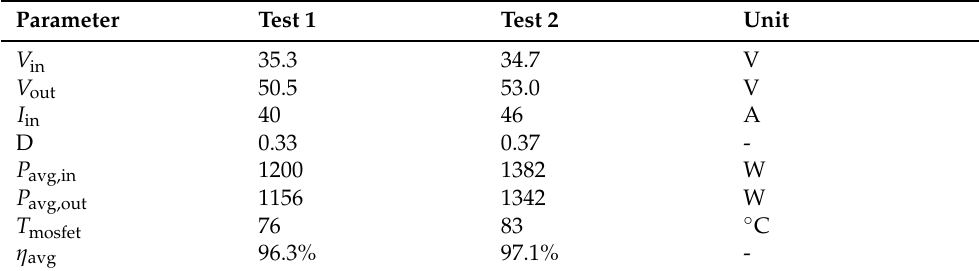
Figure 21. PCB and mosfet temperatures for rated P in = 1.5 kW. Table 8. In-field test